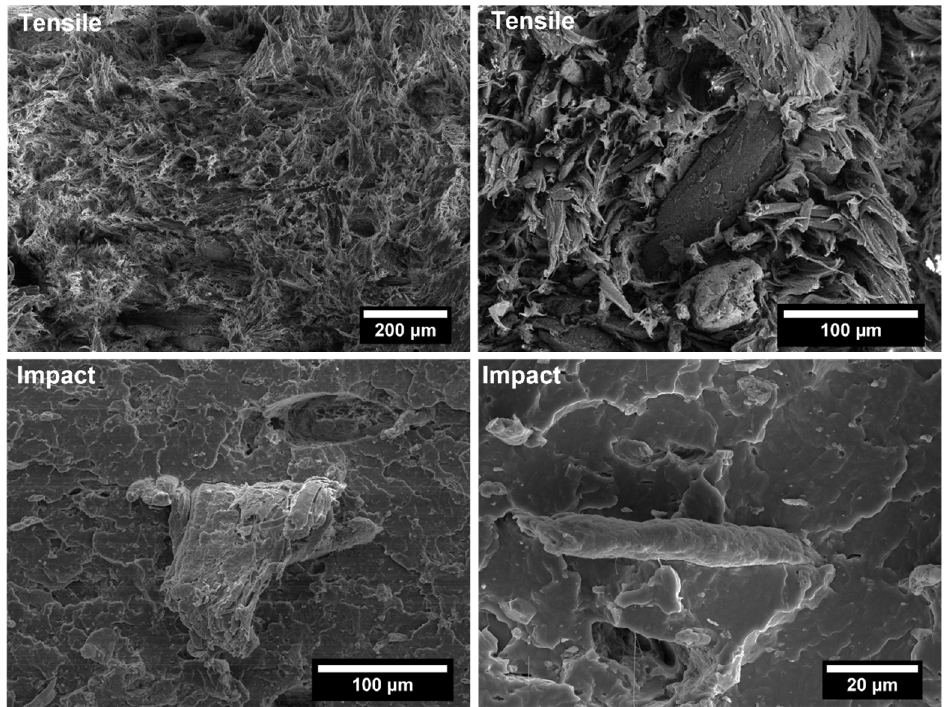
Figure 11. SEM micrographs of PP-based biocomposites with 30 wt.% of licorice root fillers without coupling agent after tensile and Charpy impact tests.